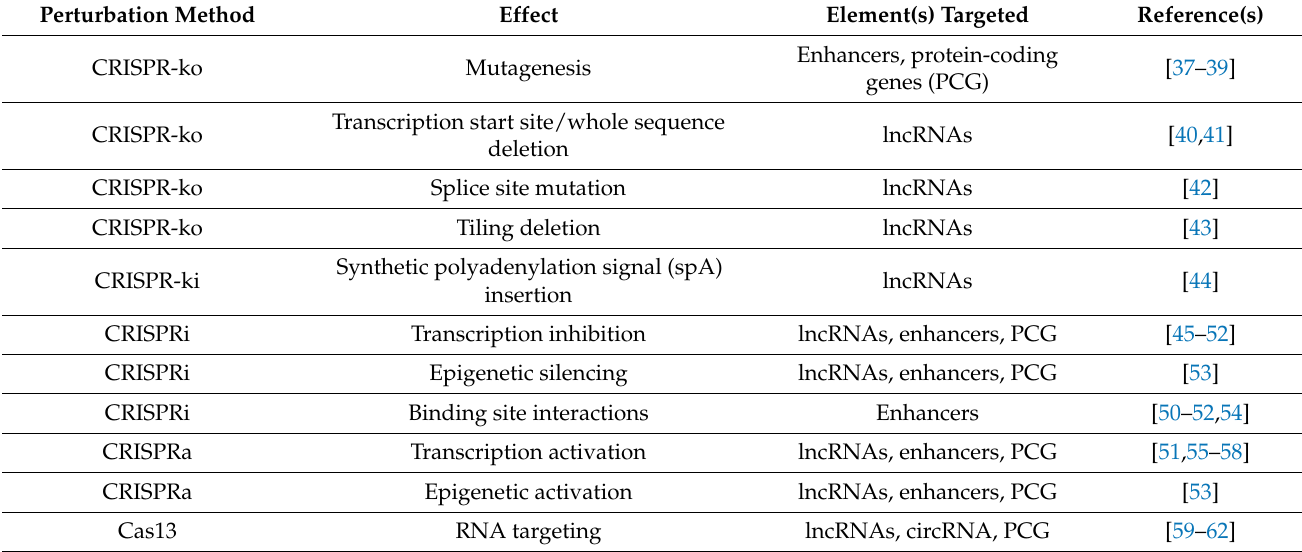
Table 1. Major approaches for high-throughput analysis of regulatory